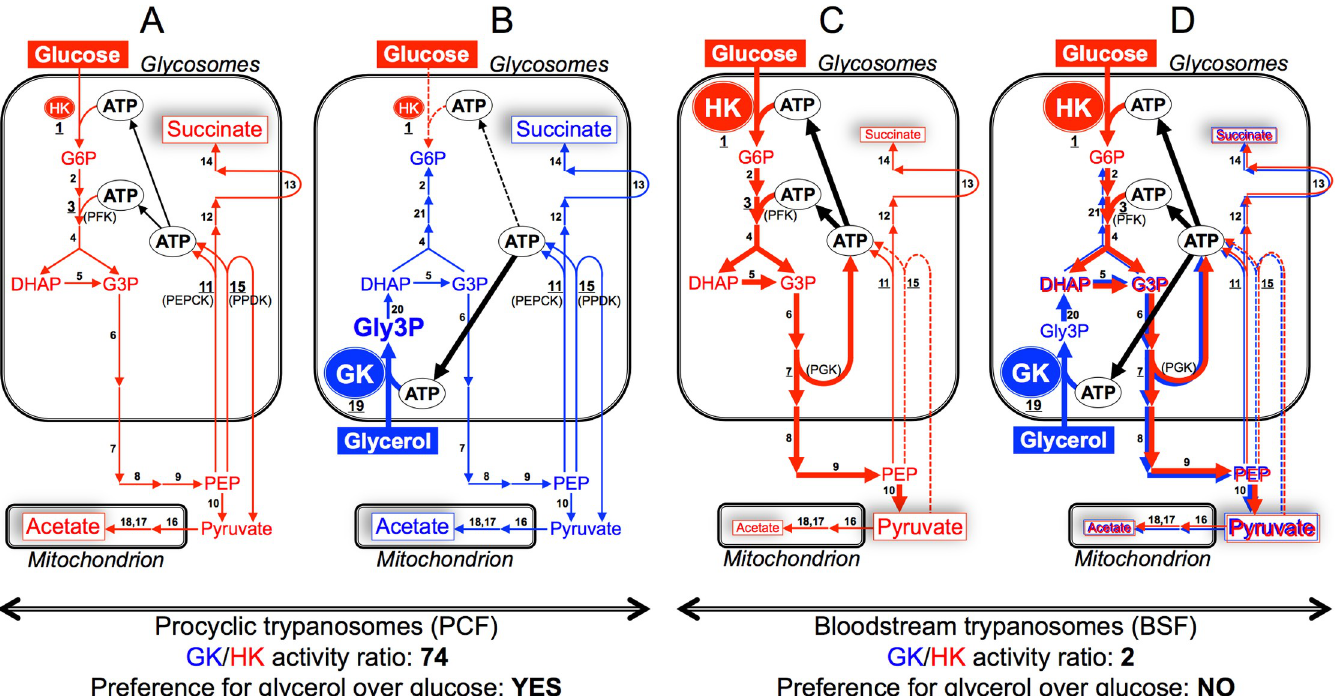
Fig 1. Mechanism of metabolic contest between glycosomal HK and GK. Pathways leading to excretion of end products (succinate, acetate, and pyruvate, highlighted in white rectangle) from metabolism of glucose and glycerol are indicated in red and blue, respectively. The production and consumption of ATP within the glycosomes are indicated and maintenance of the glycosomal ATP balance is highlighted by black arrows. The thickness of the arrows reflects metabolic fluxes and metabolic steps detected only at relatively very low activity or not at all are represented by dotted lines. The GK/HK activity ratio for procyclic and bloodstream forms is indicated below the corresponding schemes (A–B and C–D, respectively). Enzymes are (those underlined are glycosomal kinases producing or consuming ATP) the following: